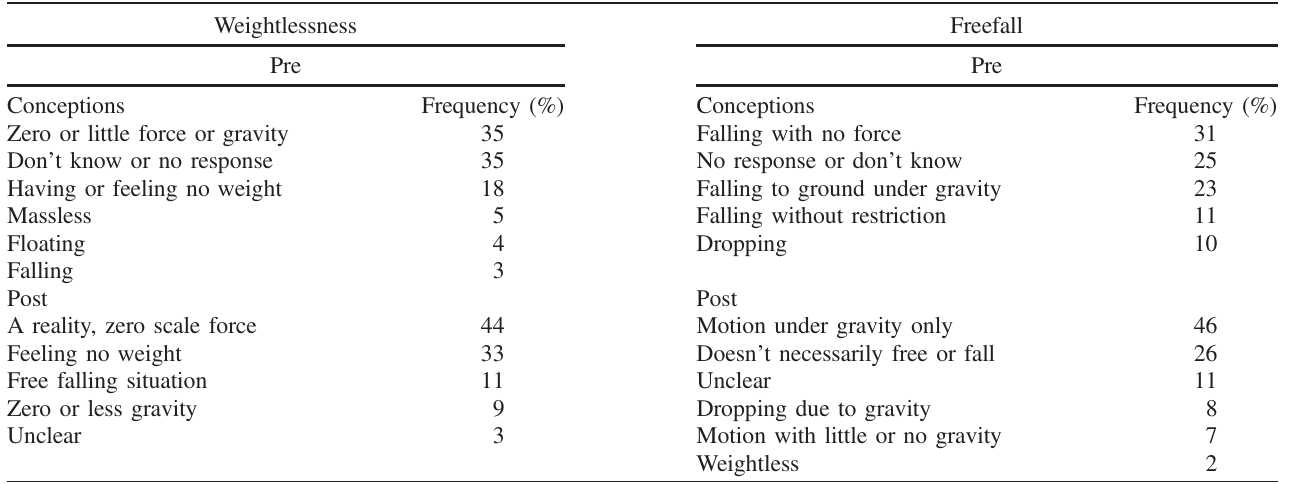
TABLE V. Student conceptions of weightlessness and free fall, pre- and pos